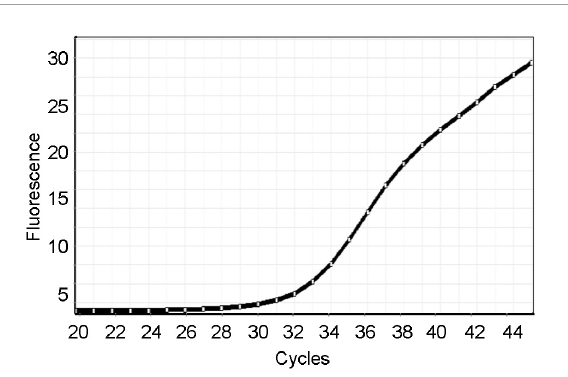
FIGURE2 The amplification plot of the laboratory real-time RT-PCR using a nucleocapsid phosphoprotein gene-specific primer set.